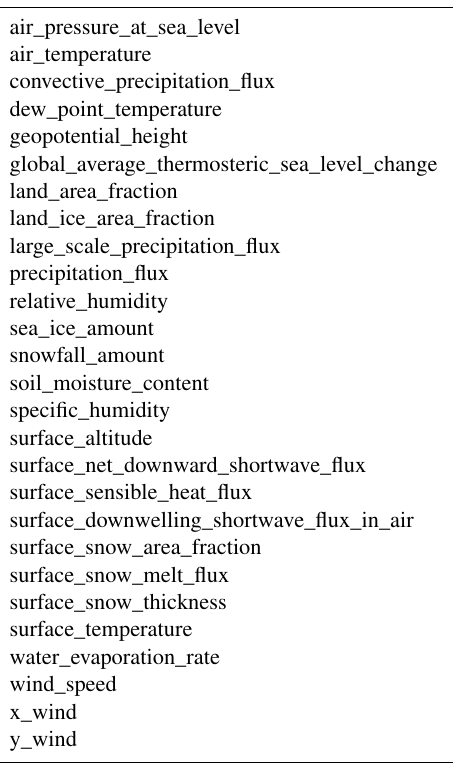
Table A1. Core variables of the Reference Data Archive in CF stan- dard name